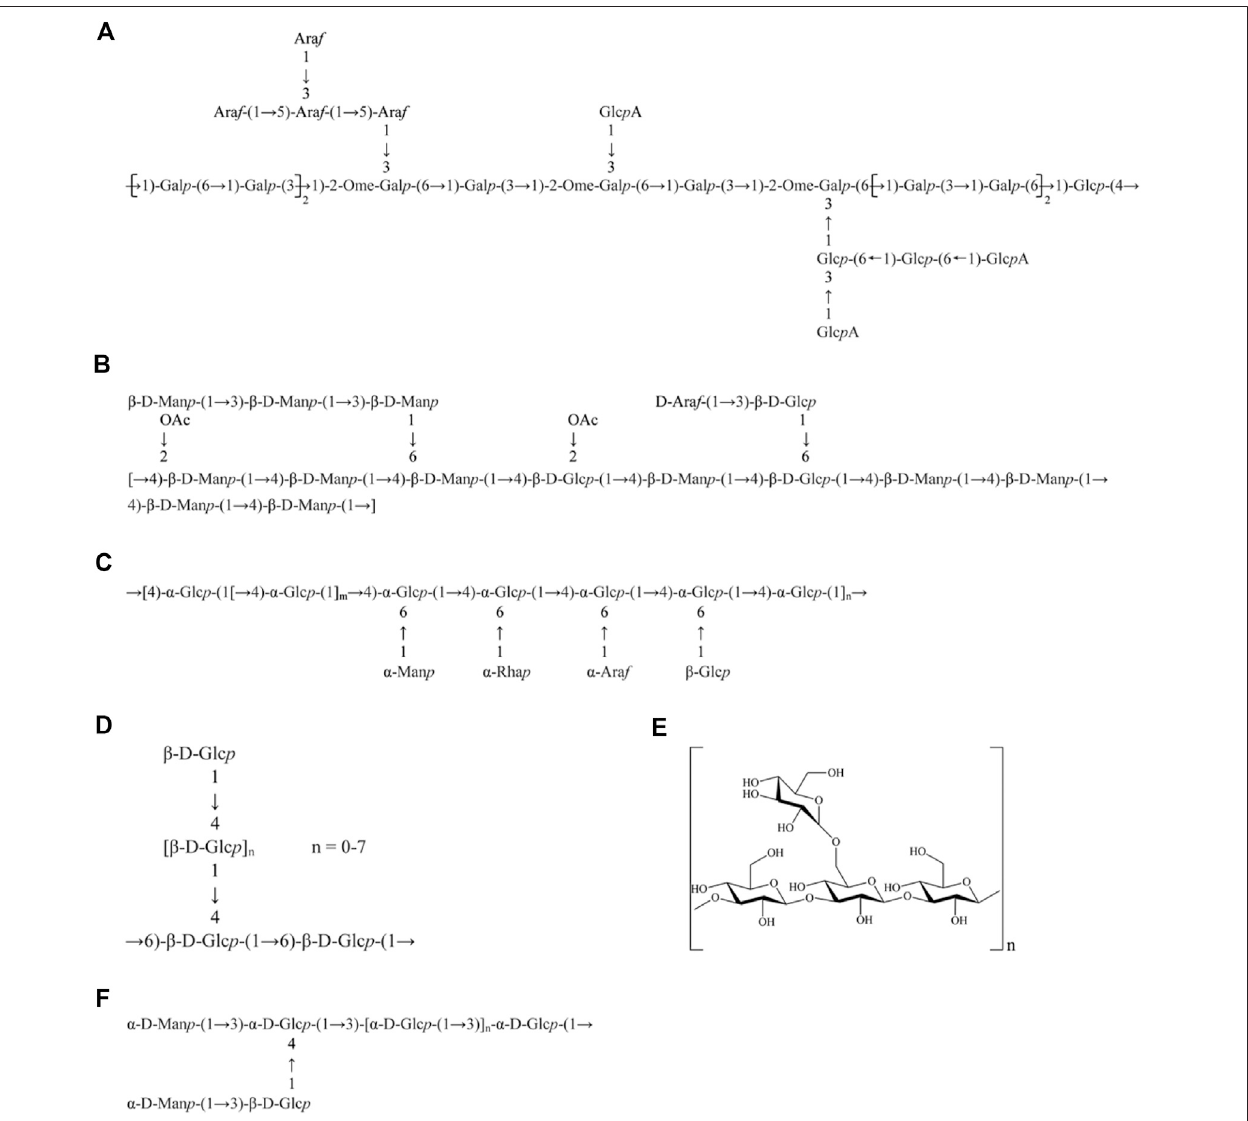
FIGURE 3 | Chemical structures of polysaccharides from natural sources for the treatment of IBD. (A) ASP from Angelica sinensis ; (B) DOPS from Dendrobium of fi cinale ; (C) ASPP from Ipomoea batatas ; (D) GLP from Ganoderma lucidum ; (E) DIP from Dictyophora indusiata ; and (F) EP-1 from Hericium erinaceus .